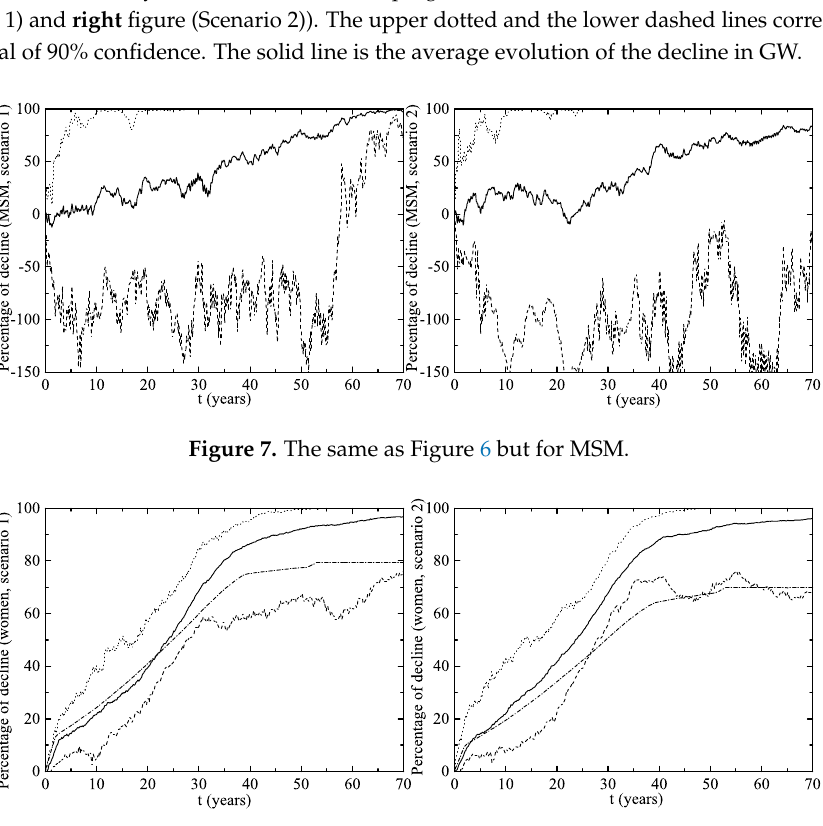
Figure 8. Percentage of decline in GW cases for women for the vaccination program in Australia ( left figure (Scenario 1) and right figure (Scenario 2)). The upper dotted and the lower dashed lines correspond to an interval of 90% confidence. The solid line is the average evolution of the decline in GW for the whole female population and the dashed-dotted line is percentage of vaccinated women. Notice the herd immunity effect also contributes to the decline in the number of infections for unvaccinated women. This can be seen when the decline lines are over the vaccination